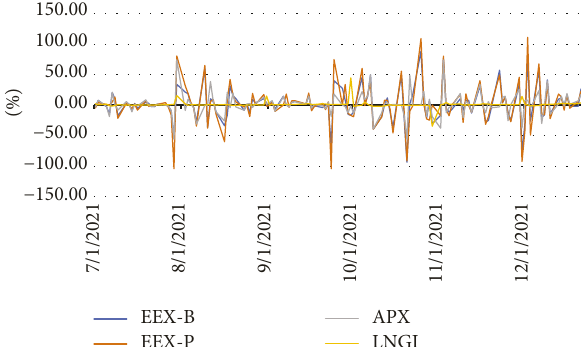
Figure 3: Evolution of COVID-19 pandemic variables. Source: